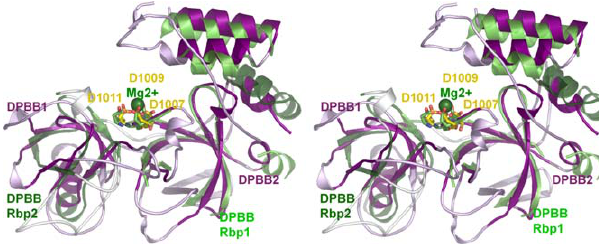
Figure 3. Comparison with DdRPs Stereo representation of the superposition of QDE-1 D N and yeast DdRP DPBBs (view as in Figure 1C). Structurally equivalent residues in QDE-1 D N are coloured dark purple (non-equivalent residues in light purple). Equivalent residues in yeast DPBBs are coloured green (non-equivalent residues in semi-transparent grey). QDE-1 D N and yeast (D481, D483, and D485) active site aspartates are coloured yellow and green respectively. DOI: 10.1371/journal.pbio.0040434.g003